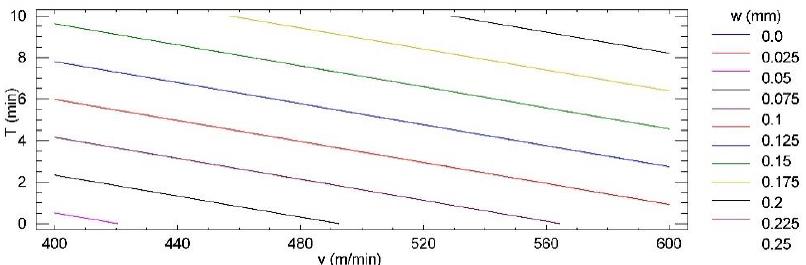
Figure 7. Contour plot for the relation between the input factors (machining time—cutting speed) and flank wear of GC4215 (ISO P15) insert.